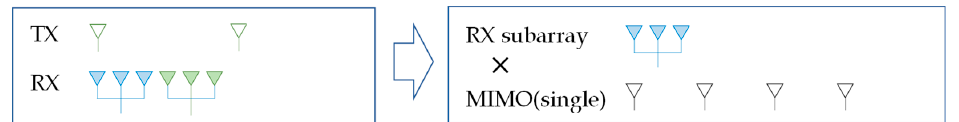
MIMO beamforming is changed in a different direction, the grating lobe and the subarray pattern modify the final pattern at the same time.